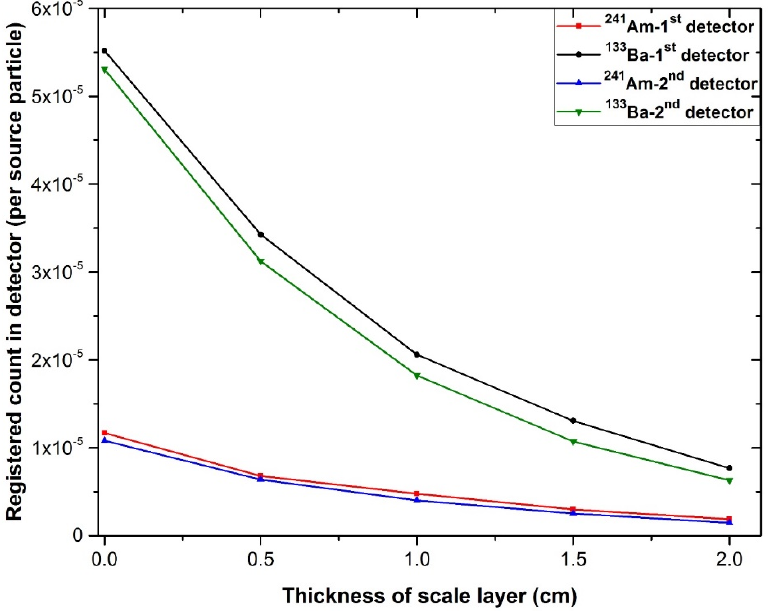
Figure 7. Registered counts in both detectors versus the changes in scale thickness for the state in which the volume fractions of components are fixed (50% gas, 30% oil, and 20% water).